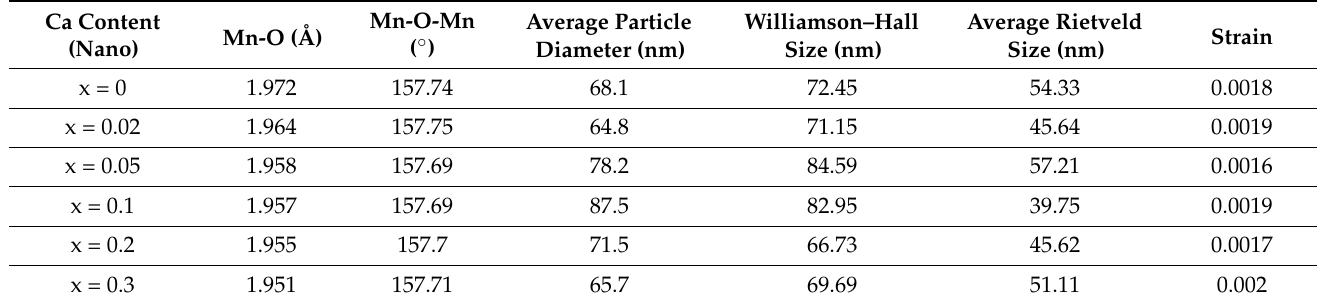
Table 2. Calculated Mn-O lengths and crystallite sizes for nanocrystalline samples using the Williamson–Hall and Rietveld methods and including grain diameters from TEM.